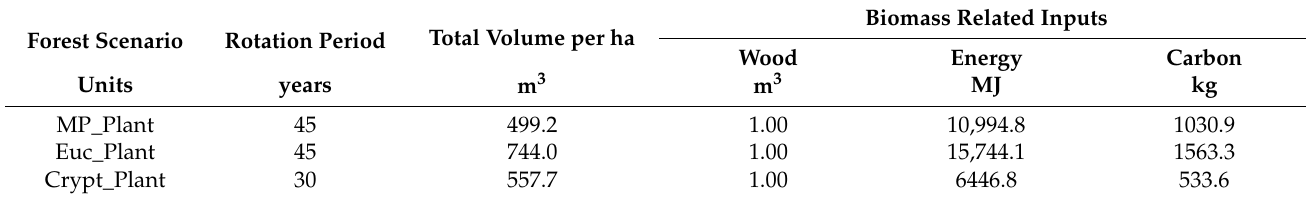
Table 3. Biomass related inputs of various forest management scenarios.